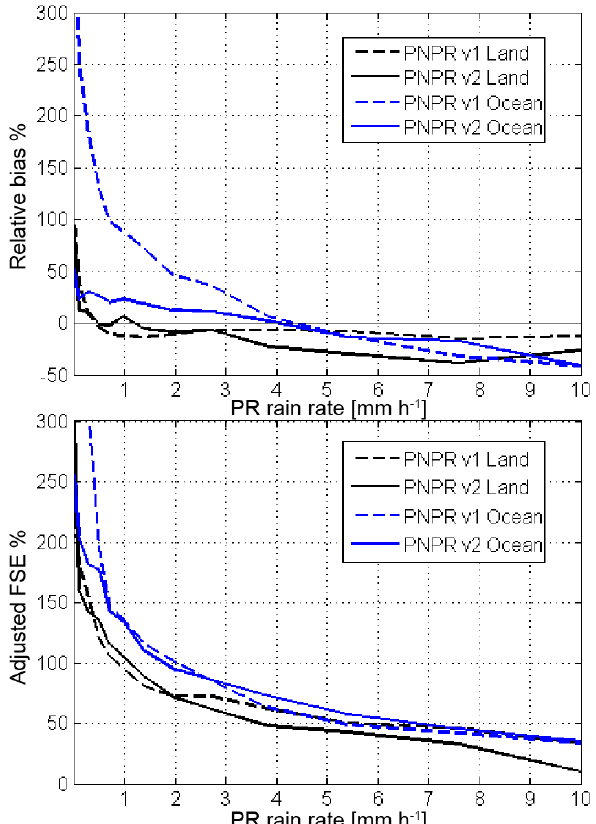
Figure 8. Relative bias percentage (top panel) and AFSE percentage (bottom panel) of PNPR v1 and PNPR v2 retrievals with respect to the TRMM-PR